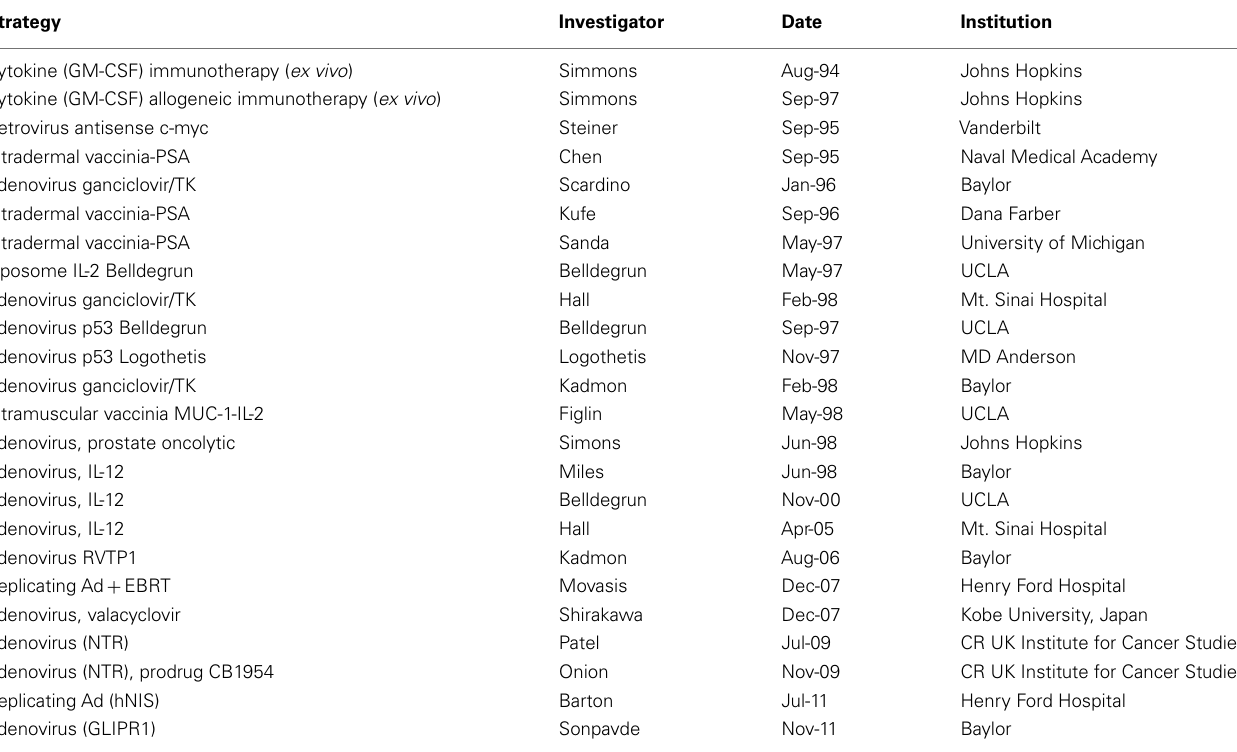
Table 1 | Prostate cancer gene therapy